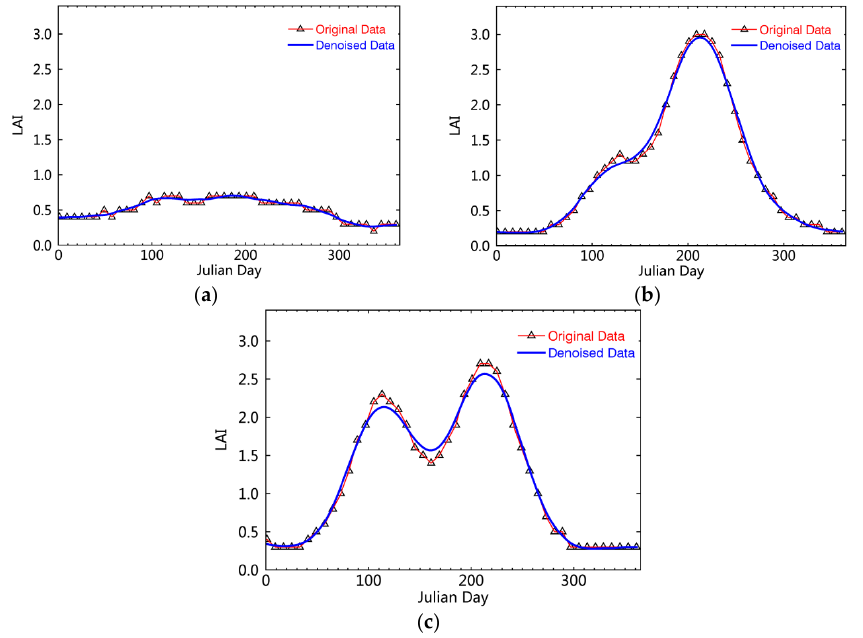
Figure 4. Smoothness of crop Leaf Area Index (LAI) time series curves in the North China Plain. ( a ) No-peak curve; ( b ) Unimodal curve; ( c ) Bimodal curve.